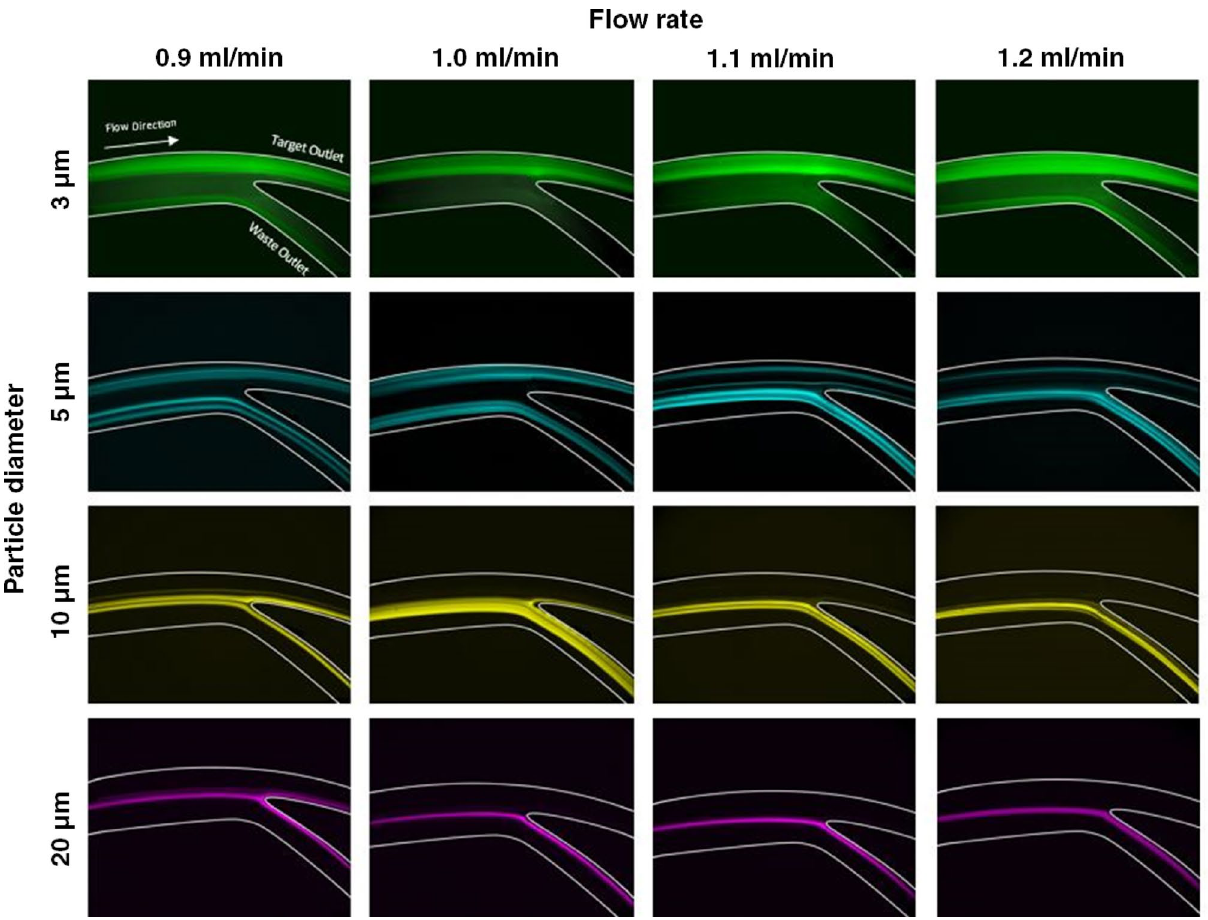
Figure 2. Focusing behaviour of tested microparticle sizes (d. 3, 5, 10, and 20 µm) at flow rates of 0.9, 1, 1.1, and 1.2